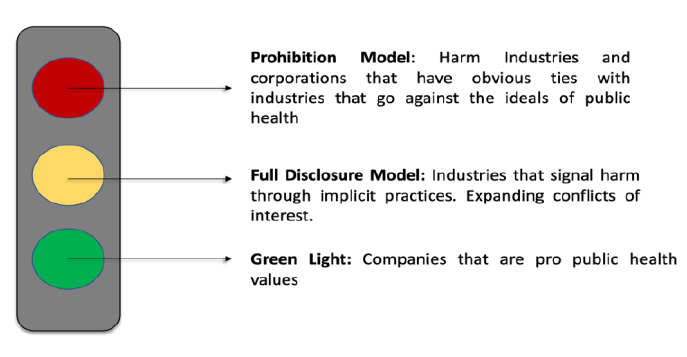
Figure 1: A Schematic of the Traffic Light